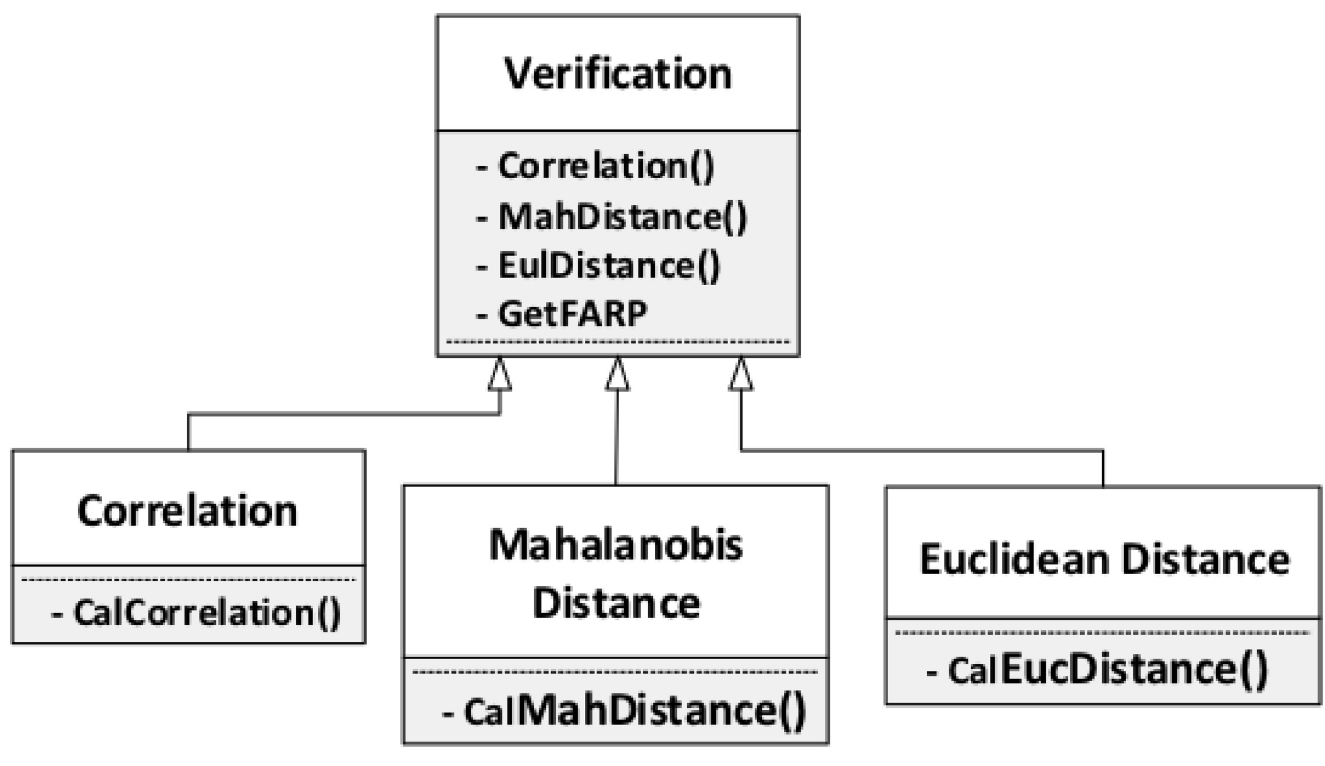
Fig 27. Verification.